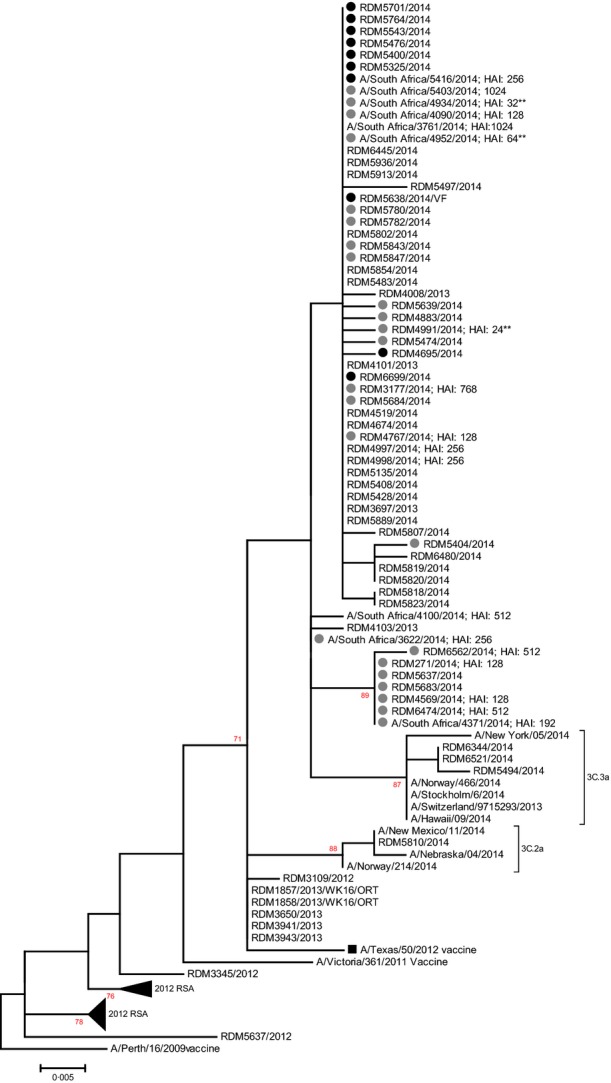
Maximum-likelihood tree of the A(H3N2) HA1 region (850 bp) including strains from the South African 2014 influenza season. The 2014 VW strains are indicated by circles (black = vaccine breakthrough strains). The 2014 Southern Hemisphere (SH) vaccine strain A/Texas/50/2012 is indicated by a black square. The emerging sub-subgroups 3C.2a and 3C.3a with low reactivity to the current vaccine are indicated. Haemagglutination inhibition titres are indicated next to strains (** low reactors).